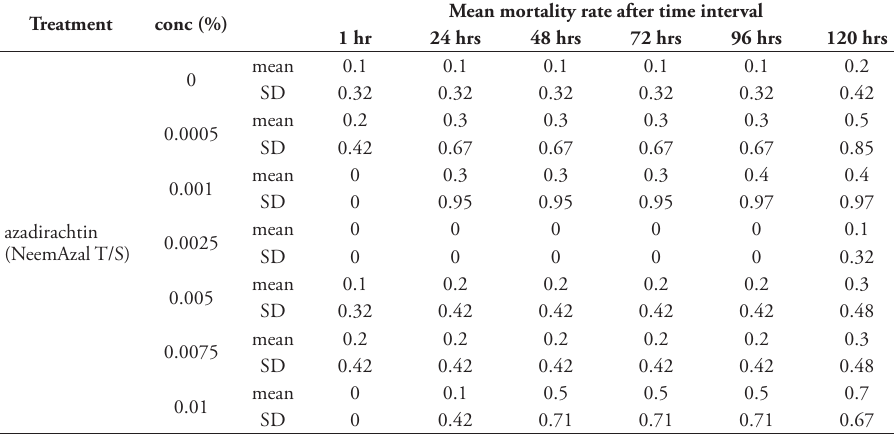
Table 1. Effect of NeemAzal on the mortality of Porcellionides pruinosus expressed as cumulative mean for different time intervals.